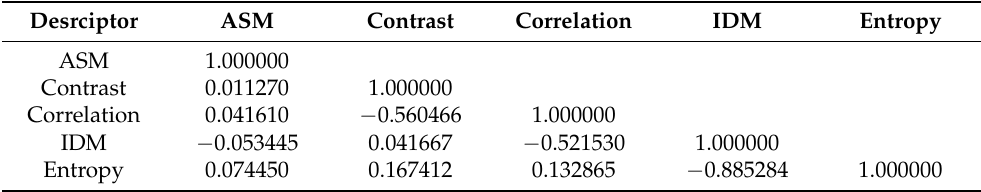
Figure 4. PCA of texture variables. Table 5. The results of correlation of texture